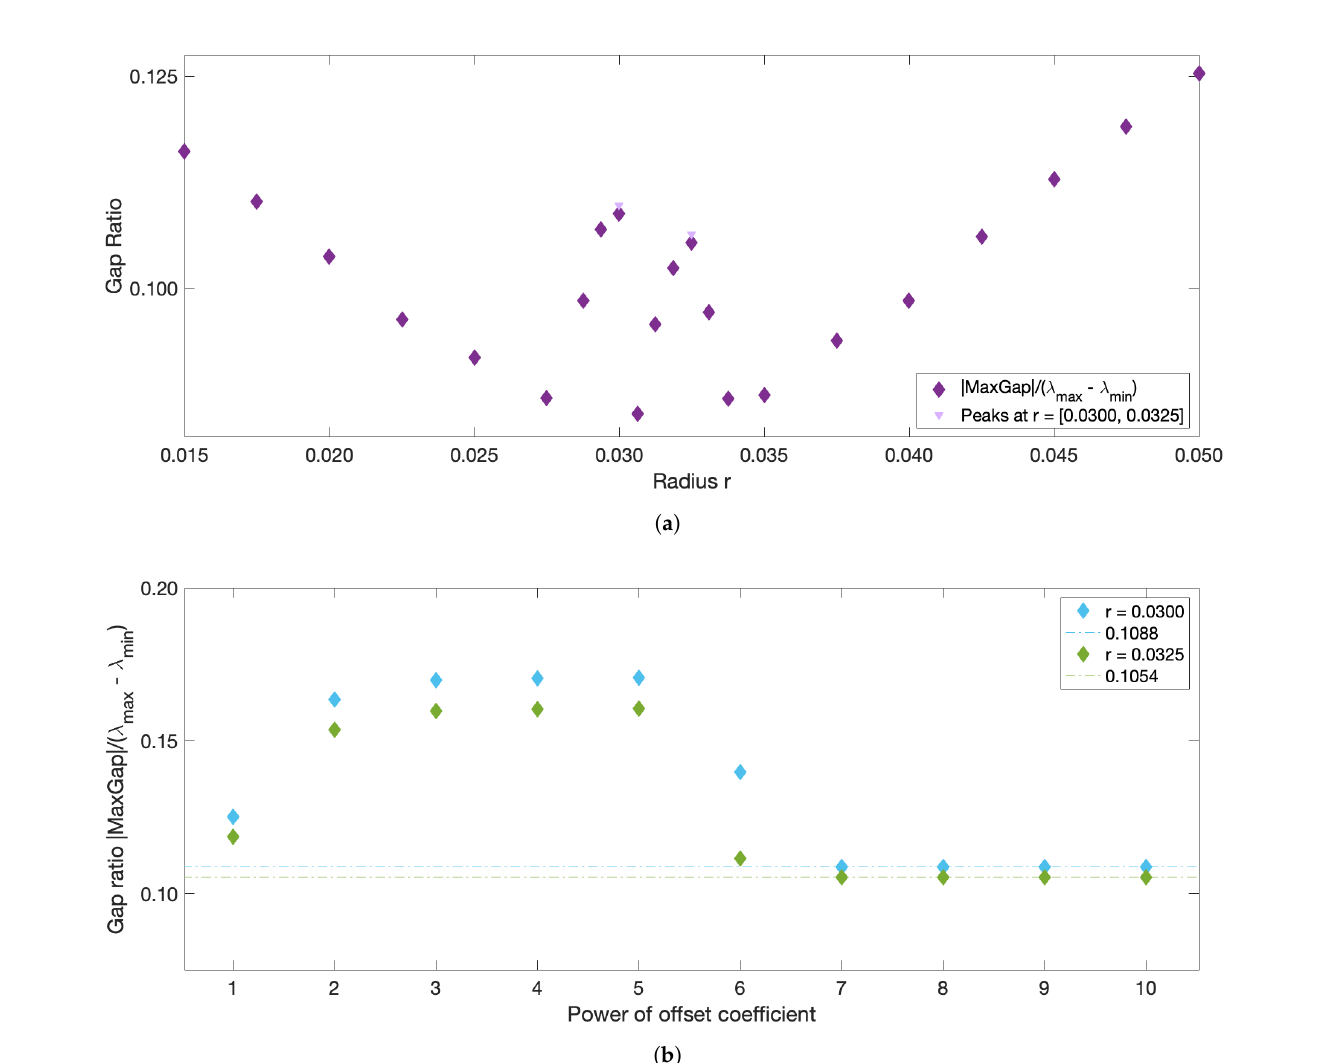
Figure A5. Steps 1 and 2 of the spectral clustering protocol for the 2018 No Man’s Land 20:00–02:00 experiment. ( a ) Sweep of r parameters with offset coefficient 10 7 for the average distance function. ( b ) Sweep of offset coefficients 10 n for average distance function and the normalized eigengap peaks from ( a